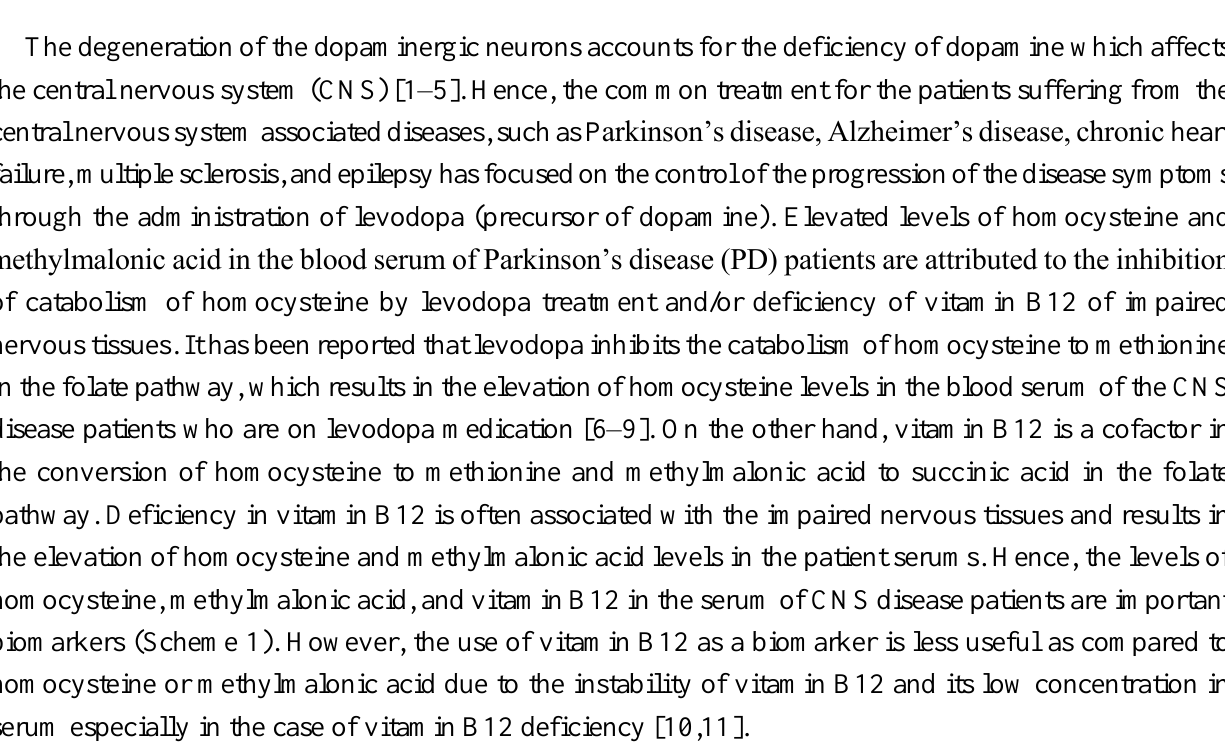
Conversions of methylmalonyl CoA to succinyl CoA and homocysteine to methionine are promoted by vitamin